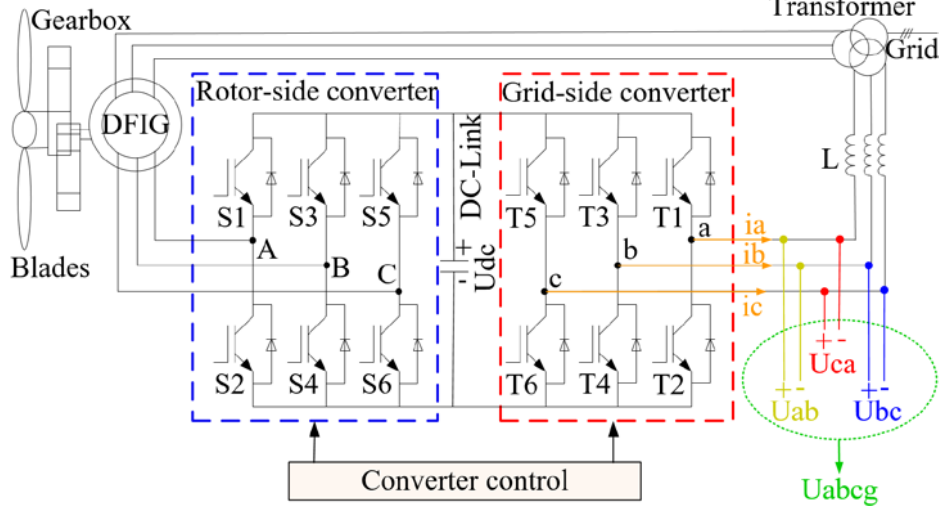
Figure 1. The topology of a wind turbine system.